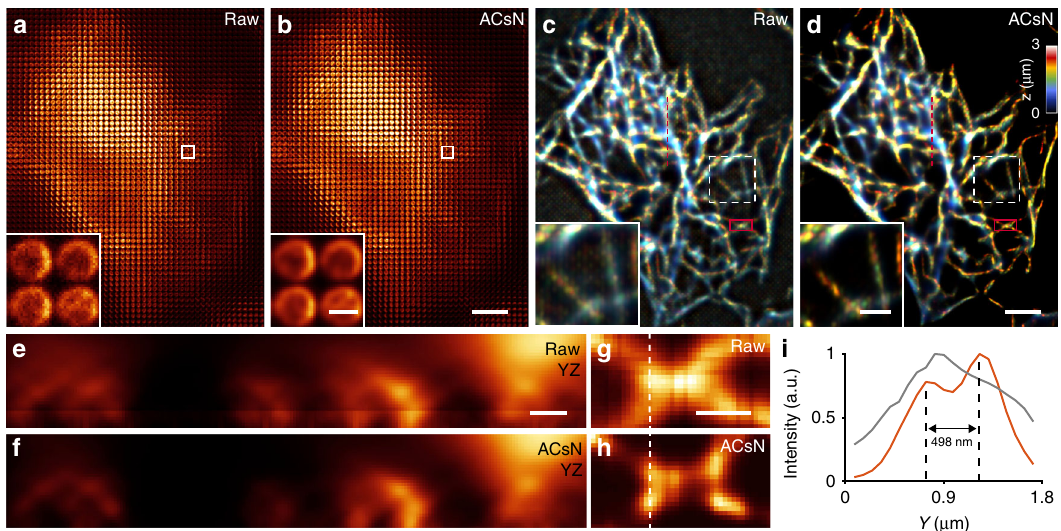
Fig. 3 ACsN denoising improves the quality of 3D reconstruction in light- fi eld microscopy. a , b Raw light- fi eld images of microtubules in a HeLa cell before ( a ) and after ( b ) ACsN processing. Insets show the zoomed-in microlens images of the corresponding boxed regions, where noise has been substantially reduced as seen in b . c , d Three-dimensional (3D) reconstructed images obtained from a and b , respectively. The depth information is coded according to the color scale bar. Insets show the zoomed-in images of the corresponding white dashed boxed regions, where better image quality and improved 3D resolution are observed after ACsN denoising. e , f Cross-sections on the YZ plane corresponding to the red dashed lines in c and d , respectively, where microtubule structures are better resolved with reduced artifacts using ACsN. g , h Zoomed-in images of the red solid boxed regions in c and d , respectively, at z = 1.4 μ m, where microtubule structures are better resolved using ACsN. i Cross-sectional pro fi les of ( g , gray) and ( h , red) corresponding to the white dashed lines in g , h , respectively. Filaments covered by non- fl uorophore-associated background noise are resolved using ACsN. Scale bars: 8 µ m ( b , d ), 800 nm ( b , inset), 3 µ m ( d , inset), 1 µ m ( e , g